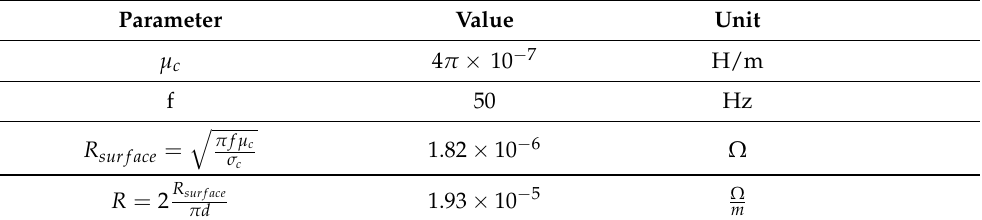
Table A2. Two-wire cable